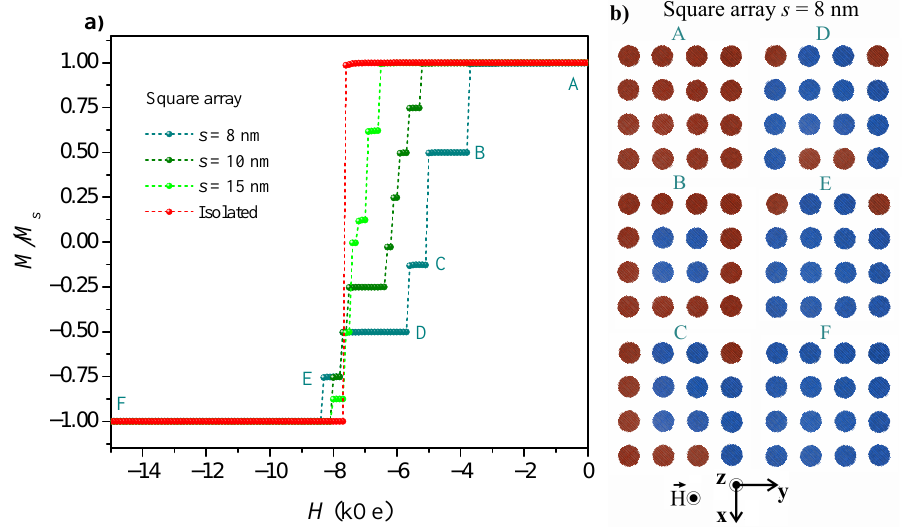
Figure 6. Hysteresis curves for square arrays of Fe cylindrical nanostructures with the aspect ratio h / d = 4, calculated for different distances between them ( a ) and a cross-section through the top of the cylindrical nanostructures in square array ( h / d = 4) with distance s = 8 nm, showing the corresponding spin configurations during the remagnetization process ( b ). The configurations A and F correspond to saturation along Oz (red color) and -Oz (blue color) field direction, respectively, while configurations from B to E correspond to the intermediate magnetization states (see the text). All configurations are indicated on the corresponding M ( H )